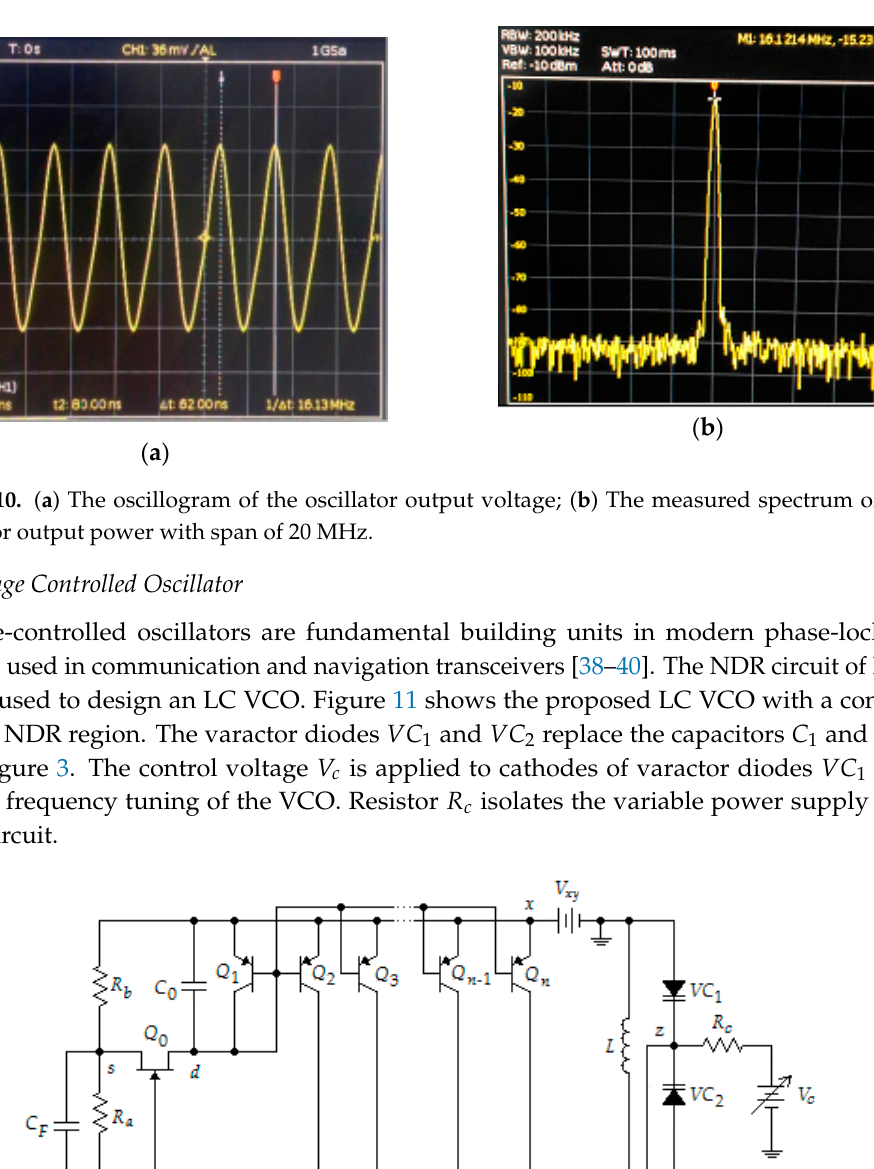
Figure 10. ( a ) The oscillogram of the oscillator output voltage; ( b ) The measured spectrum of the oscillator output power with span of 20 MHz.